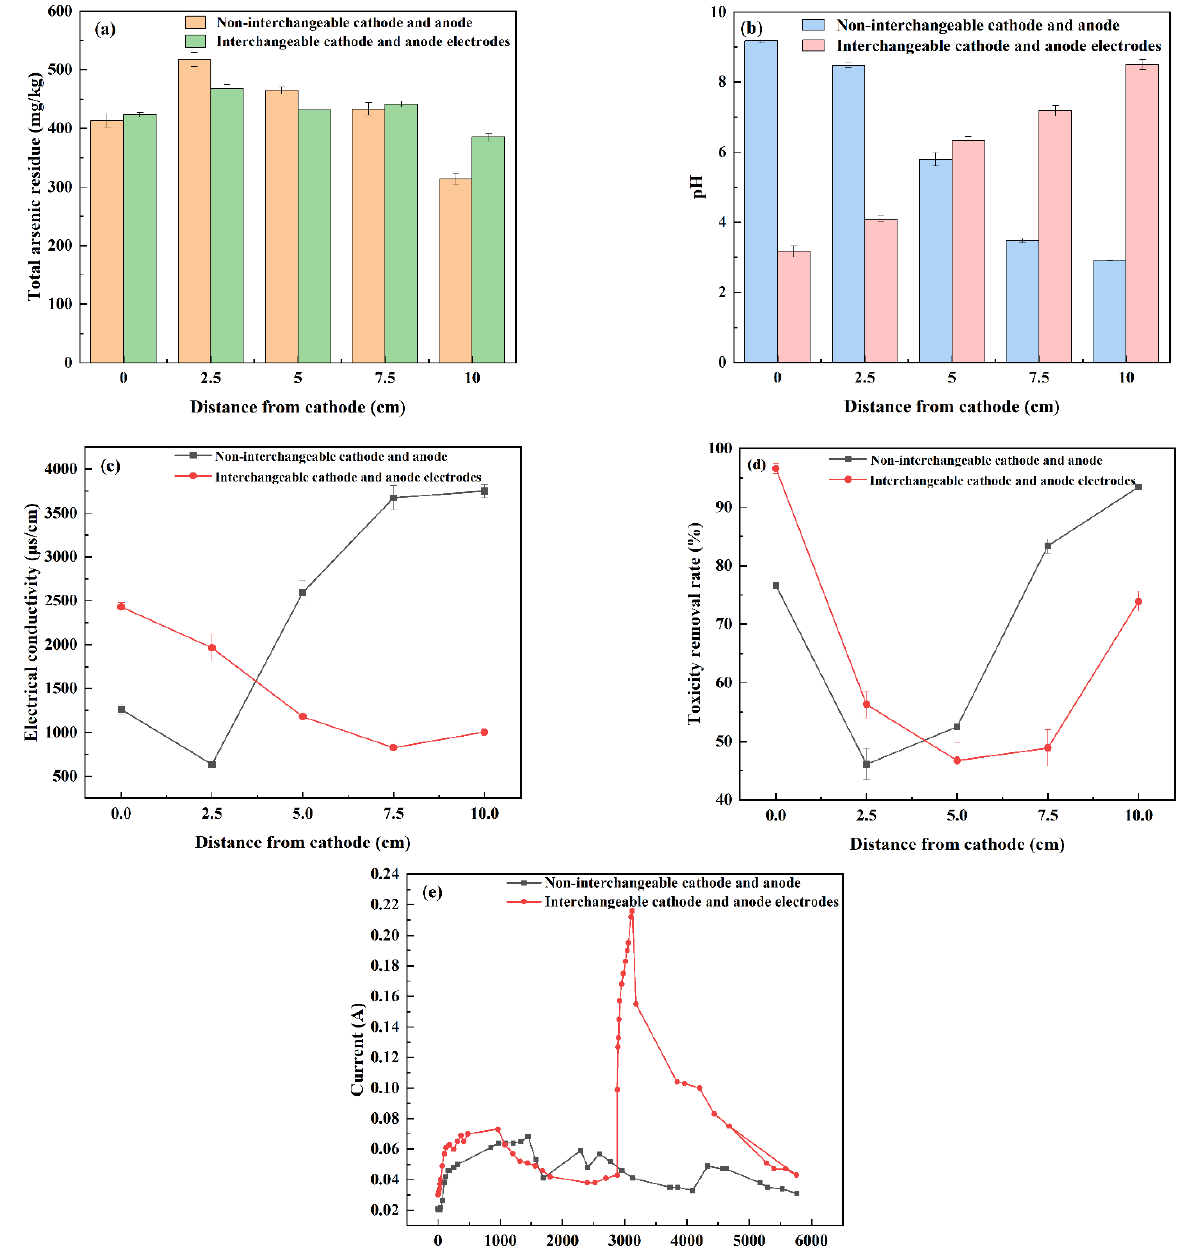
Figure 8. Effect of the exchange of cathode and anode on polarization phenomenon for the remediation of arsenic-contaminated soil by EK-PRB. Total arsenic residue ( a ), pH ( b ), electrical conductivity ( c ), toxicity removal rate ( d ) and current ( e ).